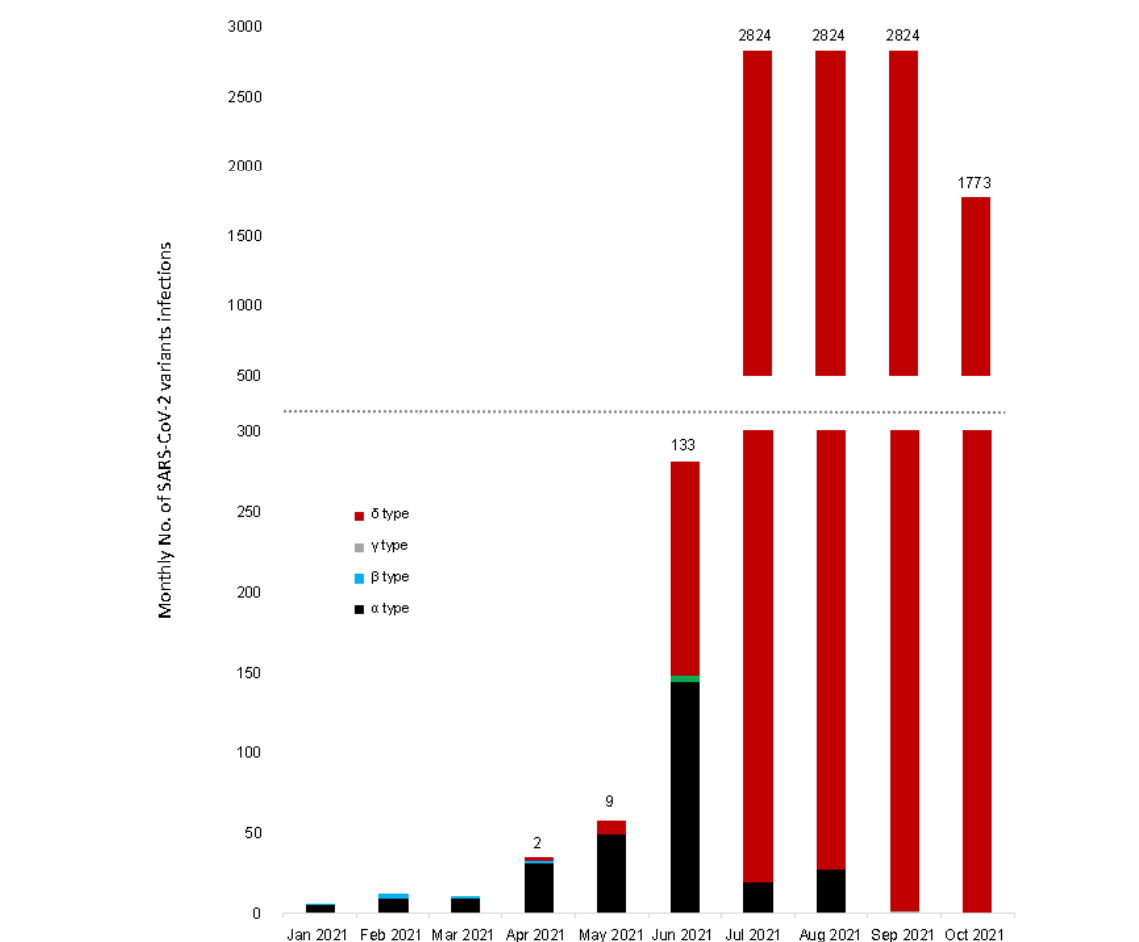
Figure 2. Cumulative number of COVID-19-vaccinated individuals, the incidence of daily SARS-CoV-2 infections, and the number of monthly SARS-CoV-2 variant infections in Seoul between April 2021 and July 2021. ( A ) Number of weekly cumulative COVID-19 vaccinated individuals as confirmed by the Daily Report of the Seoul Metropolitan Government. ( B ) Incidence of daily SARS-CoV-2 infections based on RT-PCR test results (positive). ( C ) Number of monthly SARS-CoV-2 variant infections based on the results of whole genome sequencing or partial spike gene sequencing.